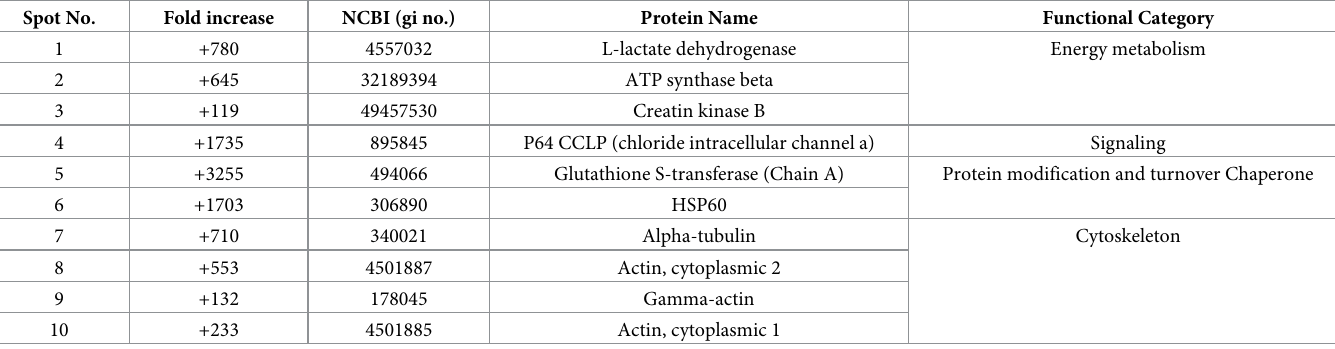
Table 1. Proteins induced by butyrate treatment in LoVo cells. Spot No. Fold increase NCBI (gi